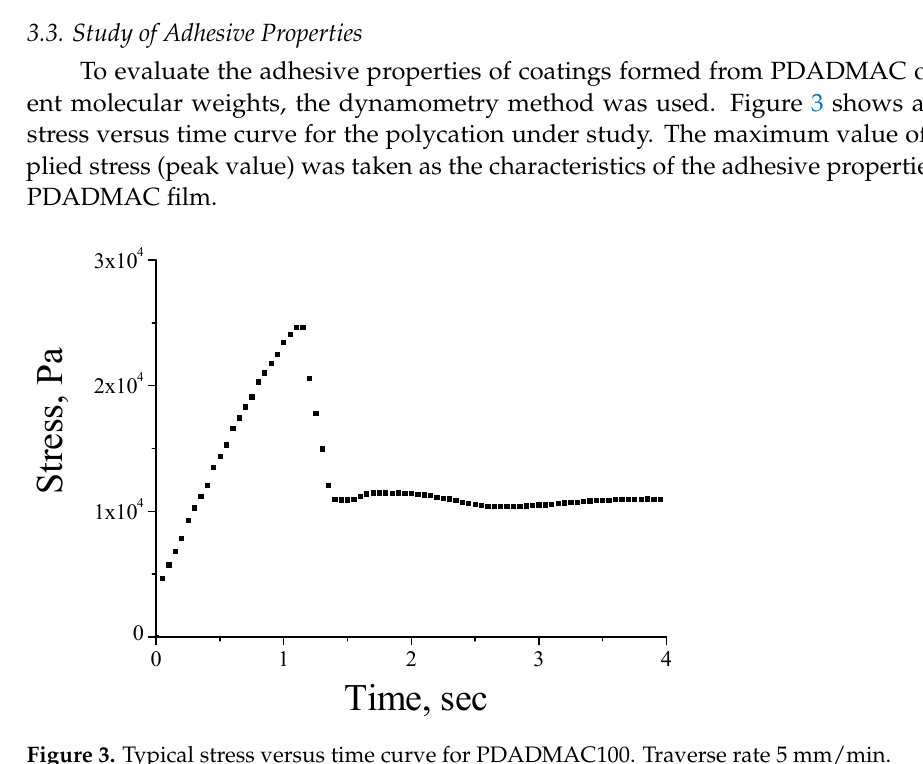
Figure 3. Typical stress versus time curve for PDADMAC100. Traverse rate 5 mm/min.